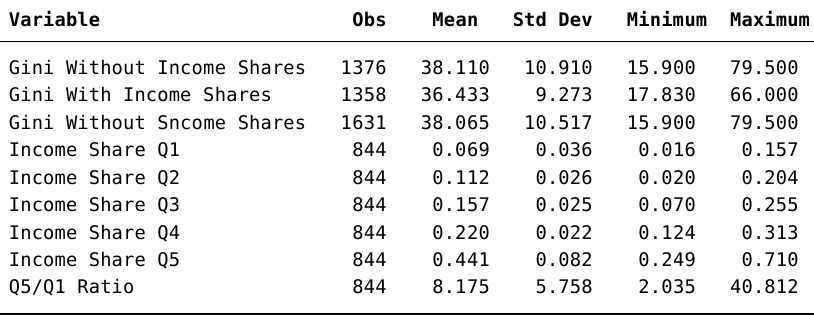
Table 2 – Unweighted, Population Weighted and Percentage Changes in the Global Gini Coefficient over